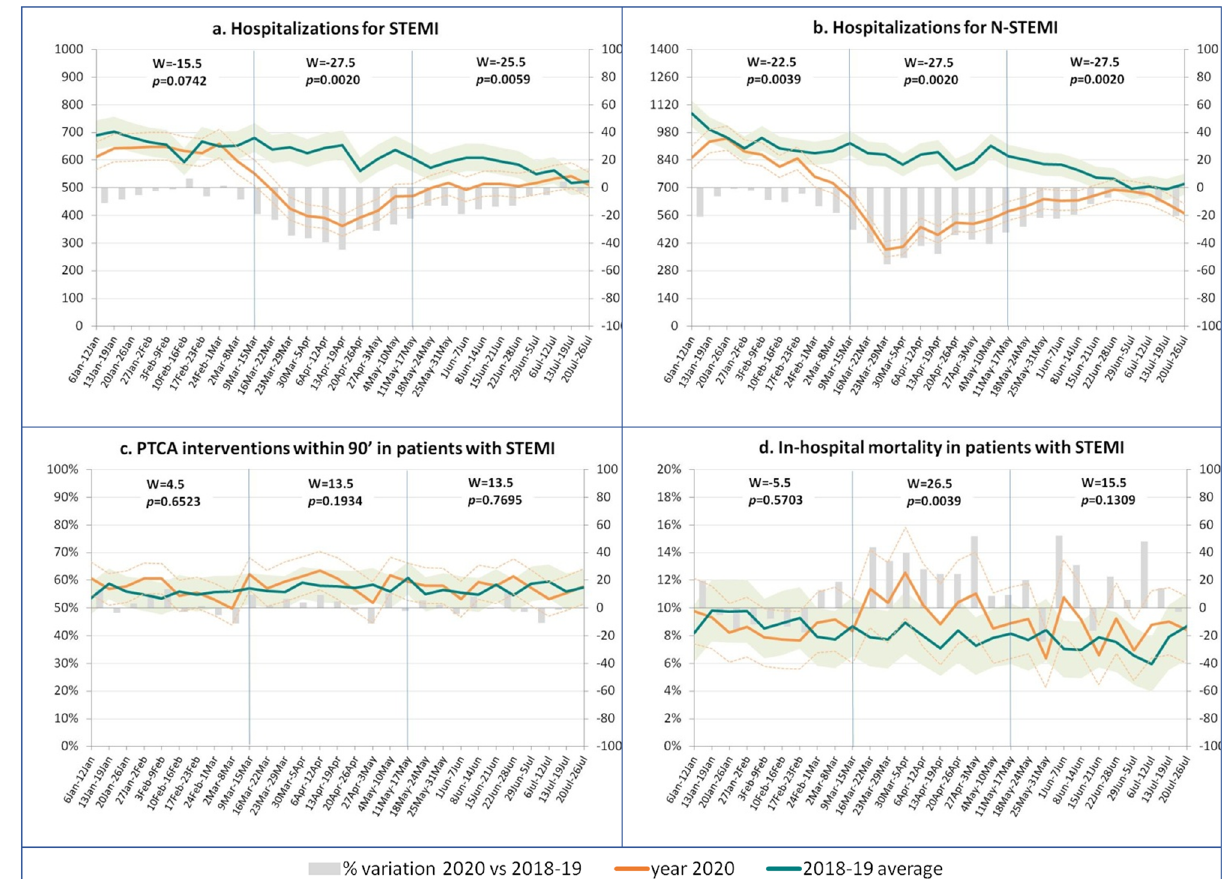
Figure 1. Impact of Covid-19 on cardiological hospital care in Italy: volumes and performance by sub-period*. Weekly trend of indicators (left axis) with 95% CI and % variations (right axis)—January–July 2020 versus 2018–2019 average. *Pre-lockdown, lockdown (9/3–17/5), post-lockdown—W values and p -values from the paired-sample Wilcoxon test for comparisons within each